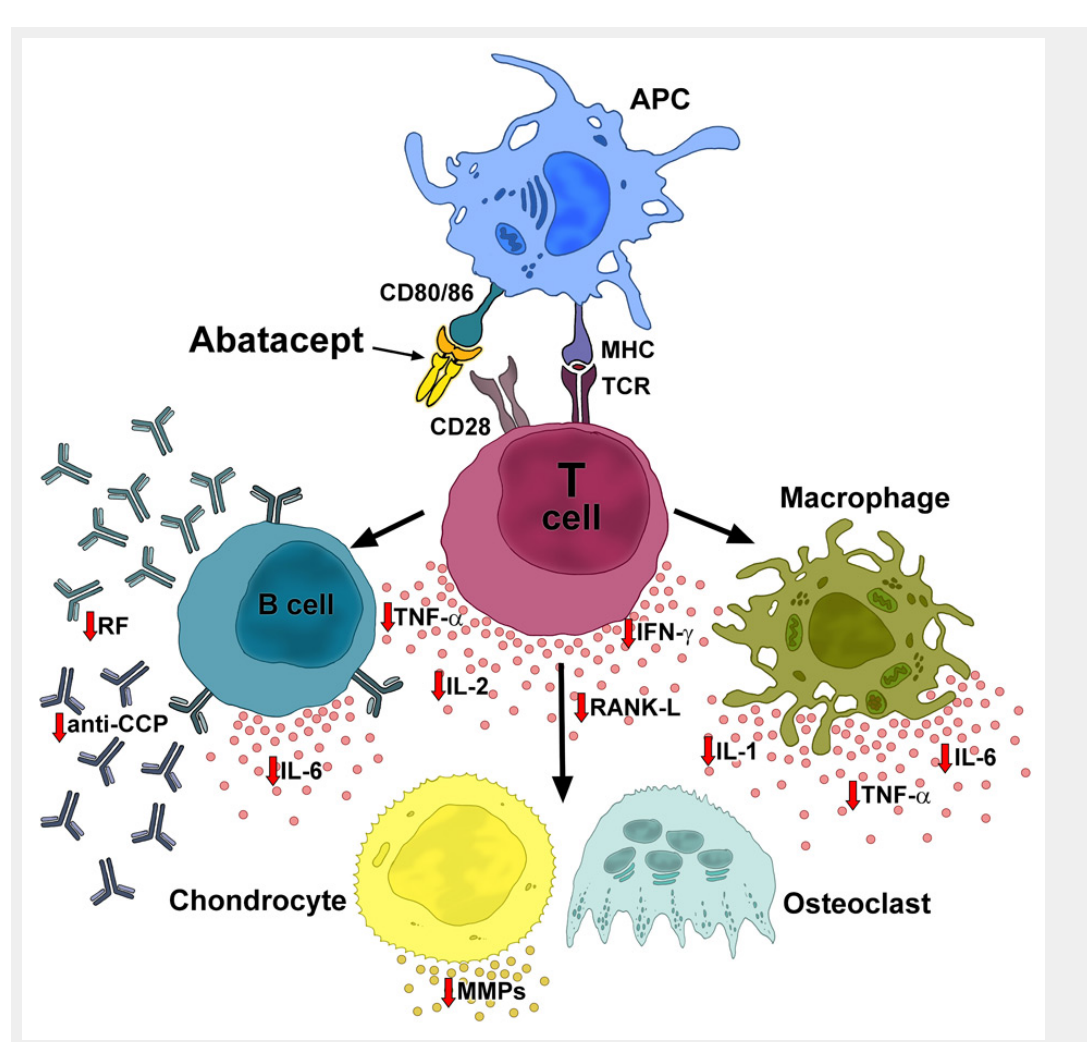
Figure 1 Mode of action of abatacept. By binding to CD80/86, abatacept blocks the interaction of CD80/86 and CD28 on the APC and T cell, respectively. The co-stimulatory pathway leading to T-cell activation is inhibited and processes in the inflammatory cascade are downregulated, resulting in normalized levels of cytokines and autoantibodies, and inhibition of osteoclast activity. APC: antigen presenting cell (e.g., macrophages, dendritic cells, B cells); MHC: major histocompatibility complex; TCR: T-cell receptor; RF: rheumatoid factor; TNF: tumour necrosis factor; IFN: interferon; IL: interleukin; anti-CCP: anti-cyclic citrullinated peptide; RANK: receptor activator of NF-κB; MMPs: matrix metalloproteinases.